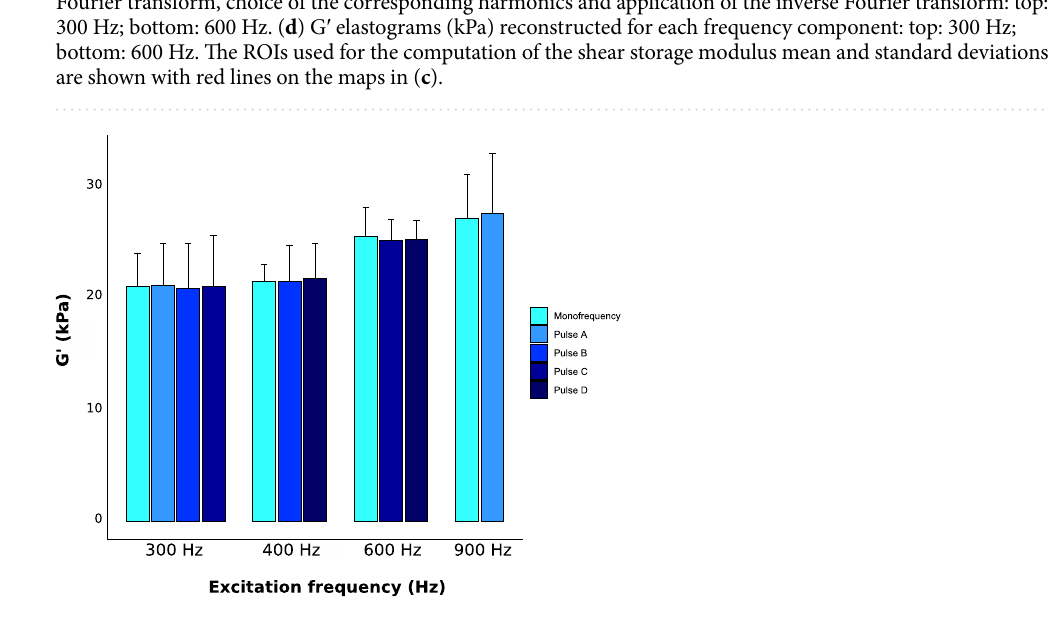
Figure 6. Mean values, with standard deviations displayed as error bars, of the reconstructed shear storage modulus G ′ for all the different excitation frequencies obtained with the classical monofrequency and the OC multifrequency